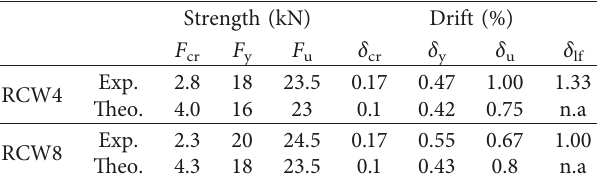
Figure 6: Crack patterns at 1% drift and hysteretic curves of all specimens: (a) RCW4; (b) RCW8. Table 1: Strength and deformation properties of specimens RCW4 and